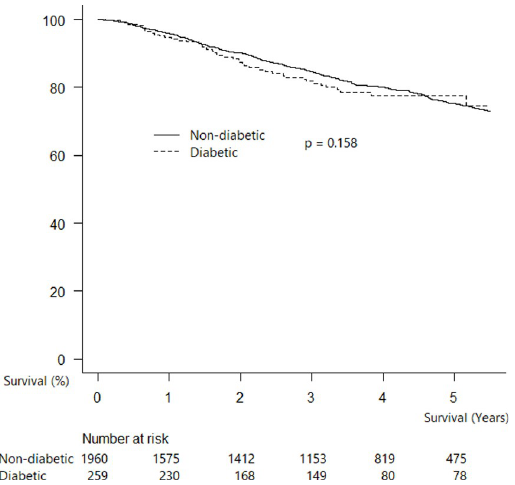
Fig 1. Kaplan–Meier survival probability curve for patients with and without DM after NSCLC resection (adjusted for age and gender).